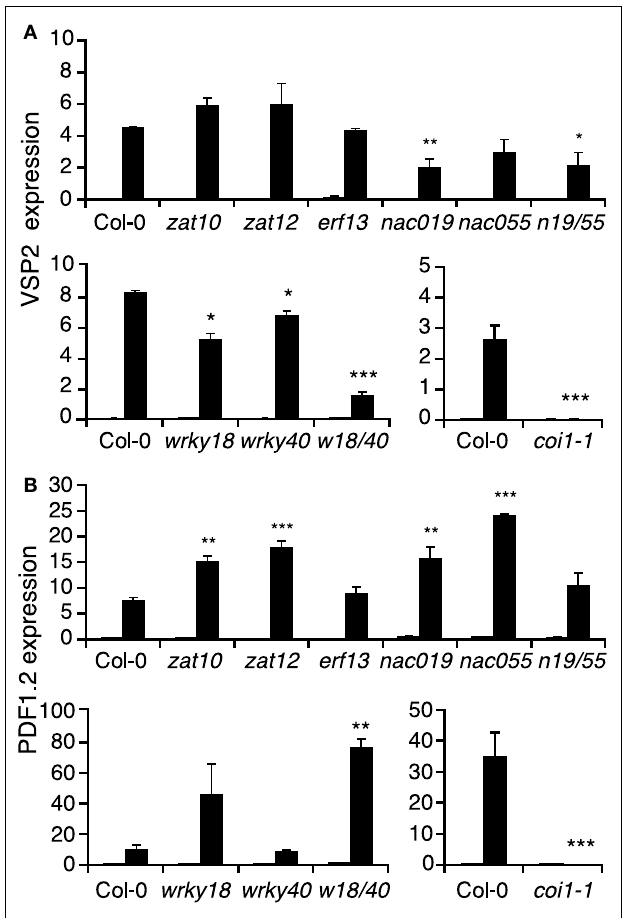
FIGURE 3 | Expression of jasmonate marker genes in transcription factor mutants. Relative expression of VSP2 (A) and PDF1.2 (B) was measured by qRT-PCR in untreated plants (white bars) and in plants challenged for 48h with S. littoralis larvae (black bars).Values are the mean ± SE of three biological replicates. Asterisks indicate statistically significant differences in treated mutant plants compared to treated Col-0 plants (Student’s t -test, * P < 0.05, ** P <